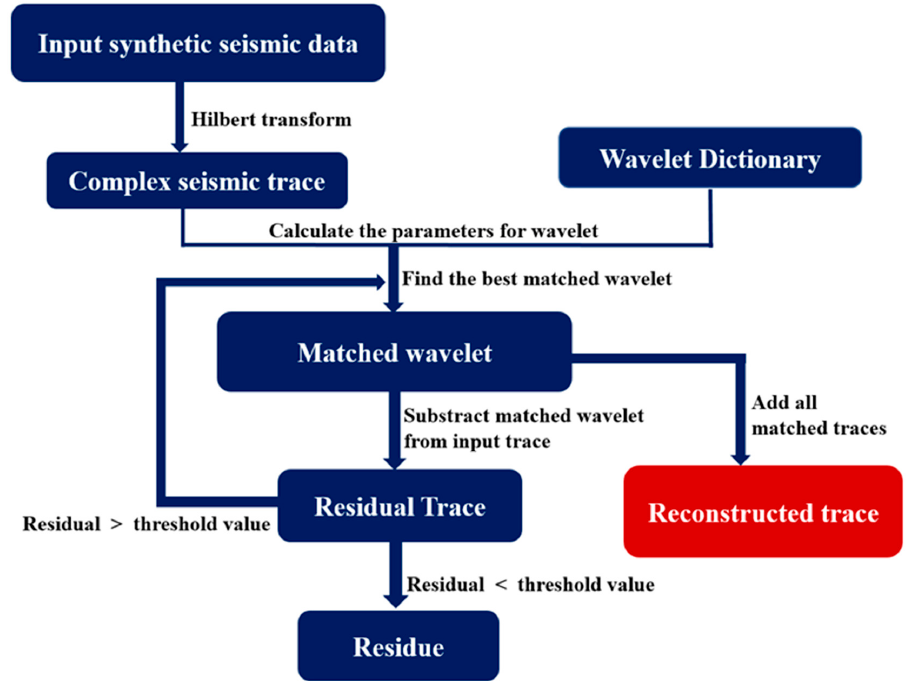
Figure 2. A flow chart of Matching